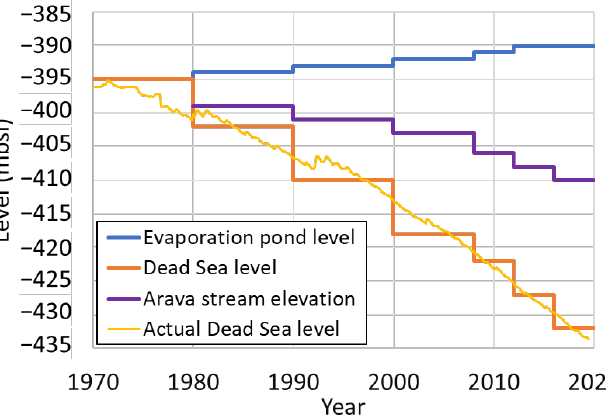
Figure 8. Approximated temporal head boundary conditions at the evaporation ponds, the Dead Sea and the Arava stream, exhibited by period steps, which were used for the numerical modeling. The actual dropping Dead Sea level is shown as well.